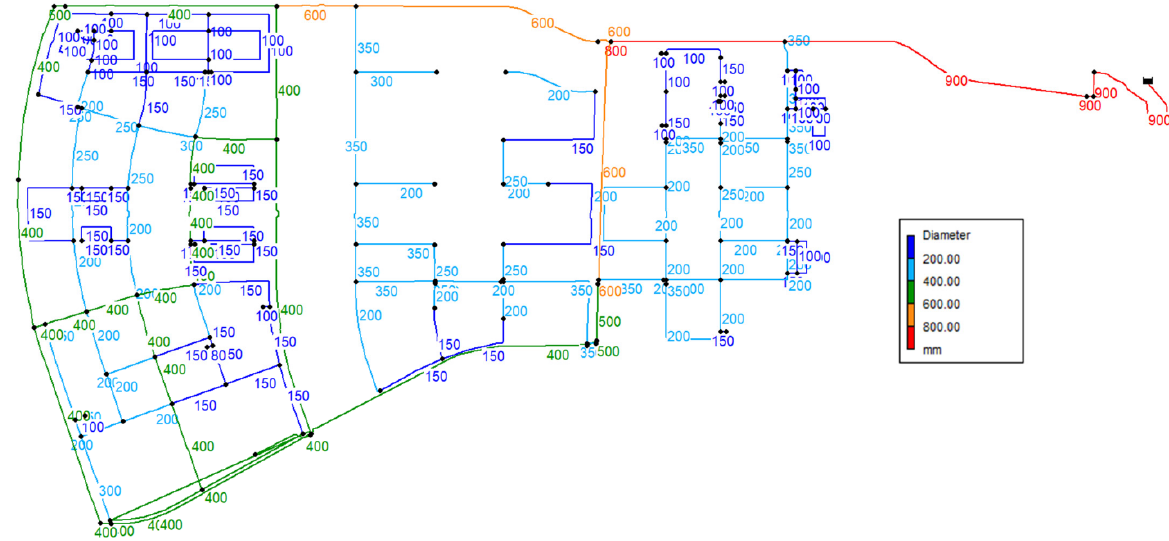
Figure 2. EPANET original model of the Cheongna WDN indicating the current pipe diameters.